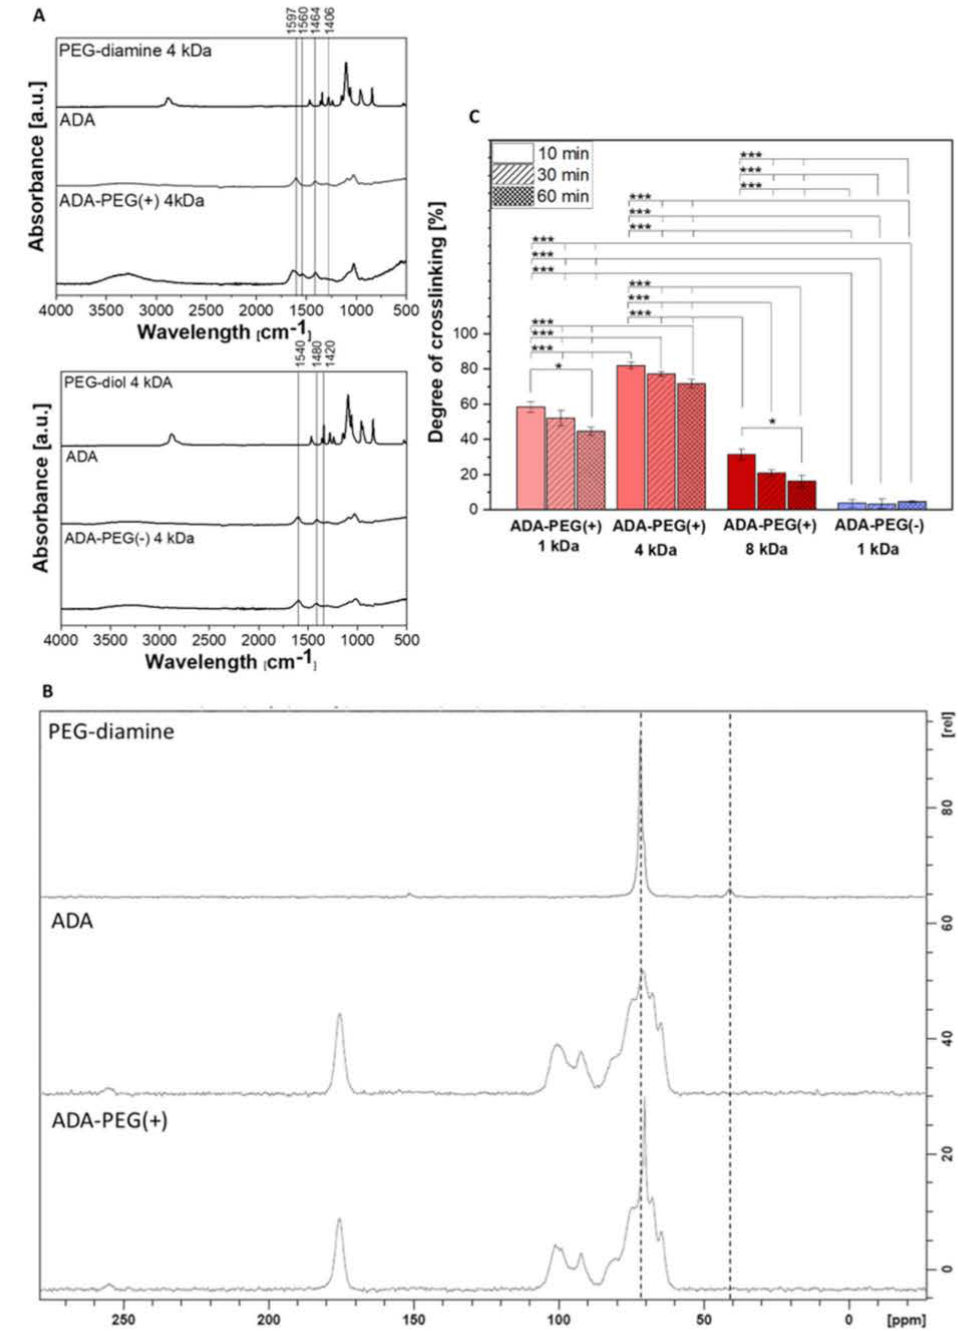
Figure 2. ( A ) FTIR spectra of ADA, PEG-Diol, PEG-Diamine and ADA-PEG inks with (+) or without (-) covalent bond; ( B ) 13 C-solid state NMR spectra of ADA, PEG-diamine and ADA-PEG(+); ( C ) degree of crosslinking of ADA-PEG inks with (+) or without (-) covalent crosslinking after a reaction time of 10, 30 and 60 min ( n = 5). ns * p < 0.05, ** p < 0.01, *** p <